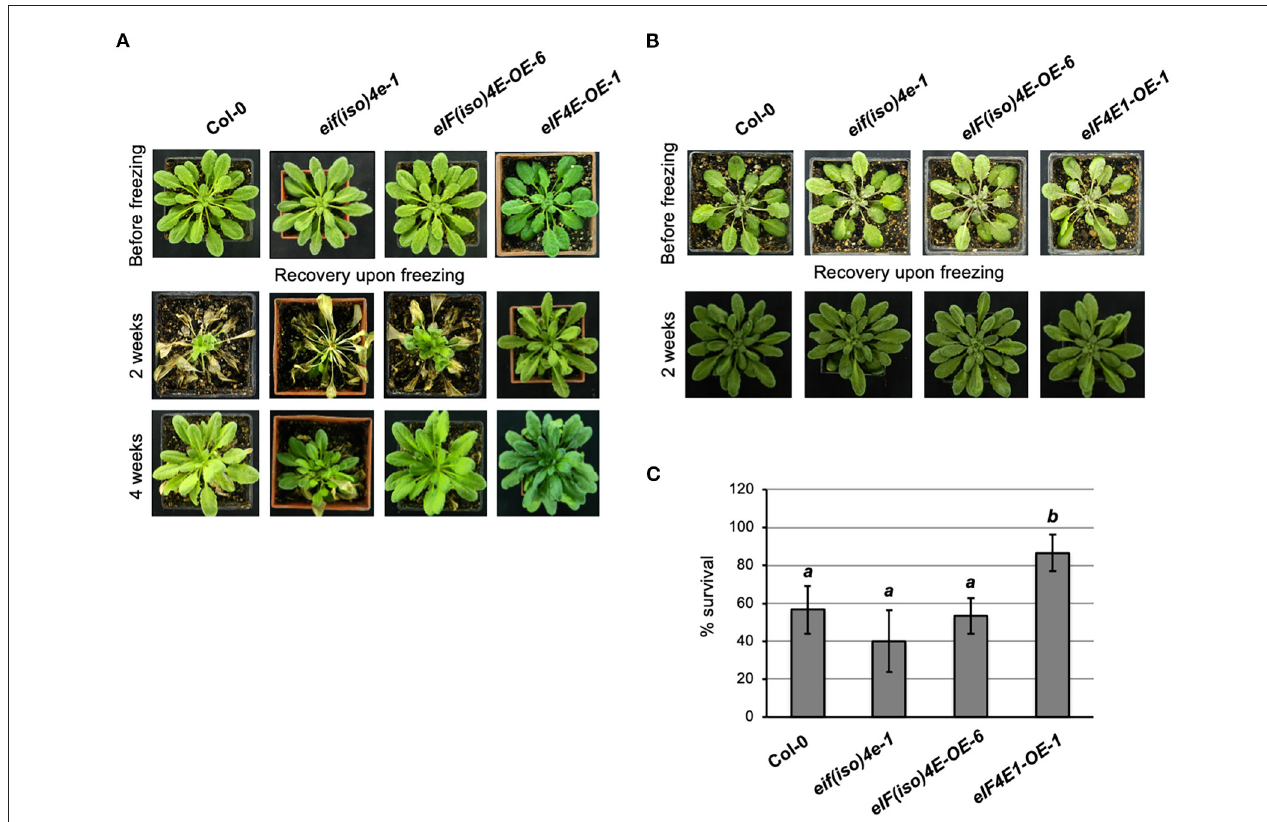
FIGURE 2 | eIF4E1 overexpression enhances Arabidopsis thaliana freezing tolerance in adult non-acclimated plants. Plant phenotypes were registered before freezing, and at 2 or 4 weeks after stress recovery. Col-0, wild type; ateif(iso)4e-1 , knockout eIF(iso)4E mutant; AteIF(iso)4E-OE-6 , plants expressing eIF(iso)4E under the CaMV 35S promoter; AteIF4E1-OE-1 , plants expressing eIF4E1 under the CaMV 35S promoter. (A) Adult 8-week-old plants were grown at 22 ◦ C under 8h light/16h darkness photoperiod (short day) and placed, without previous acclimation, under freezing temperatures ( − 20 ◦ C) for 1h. (B) Adult 7-week-old plants were grown at 22 ◦ C and for an additional week at 4 ◦ C (acclimation) under 8h light/16h darkness photoperiod (short day) previous to freezing temperature ( − 20 ◦ C) exposure for 1h. (C) Percentage of plant survival upon freezing without acclimation. Analysis was performed using one-way ANOVA followed by the Dunnett test; p <